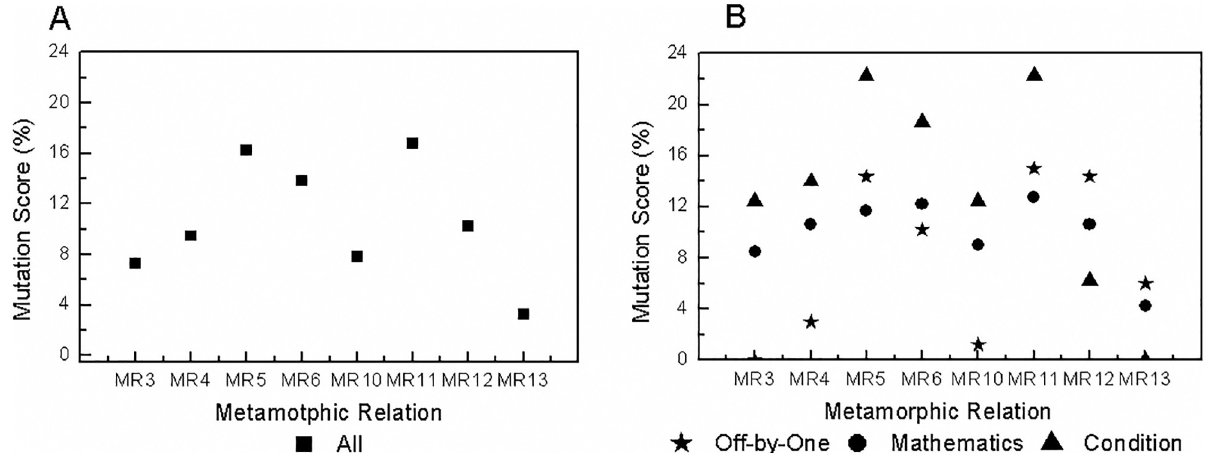
Fig 8. Mutation scores of the MRs based on the same source event sequence h Account Recharge, Electricity Bill Inquiry, Online Payment i . A: For all mutants. B: For different types of mutants.